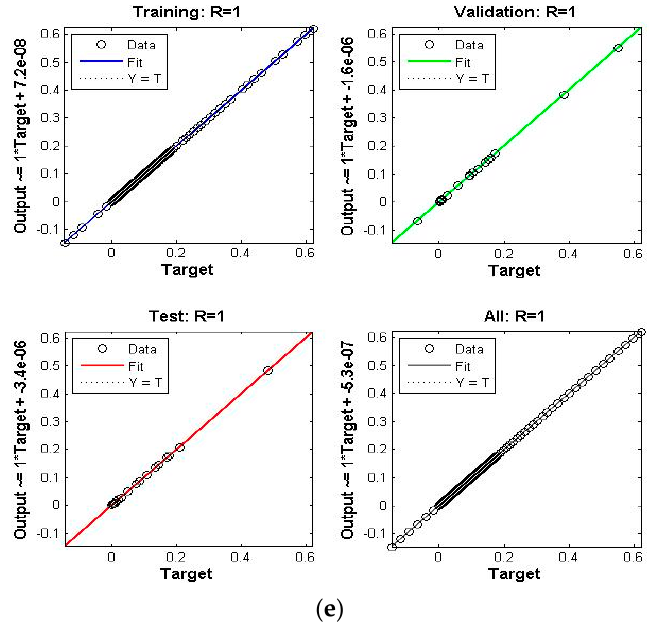
Figure 4. Scenario I Case I of TD-PNFM. ( a ) MSE Results: Scenario I Case I; ( b ) Transition state: Scenario I Case I; ( c ) Fitness: Scenario I Case I; ( d ) Error Histogram: Scenario I Case I; ( e )regression: Scenario I Case I.